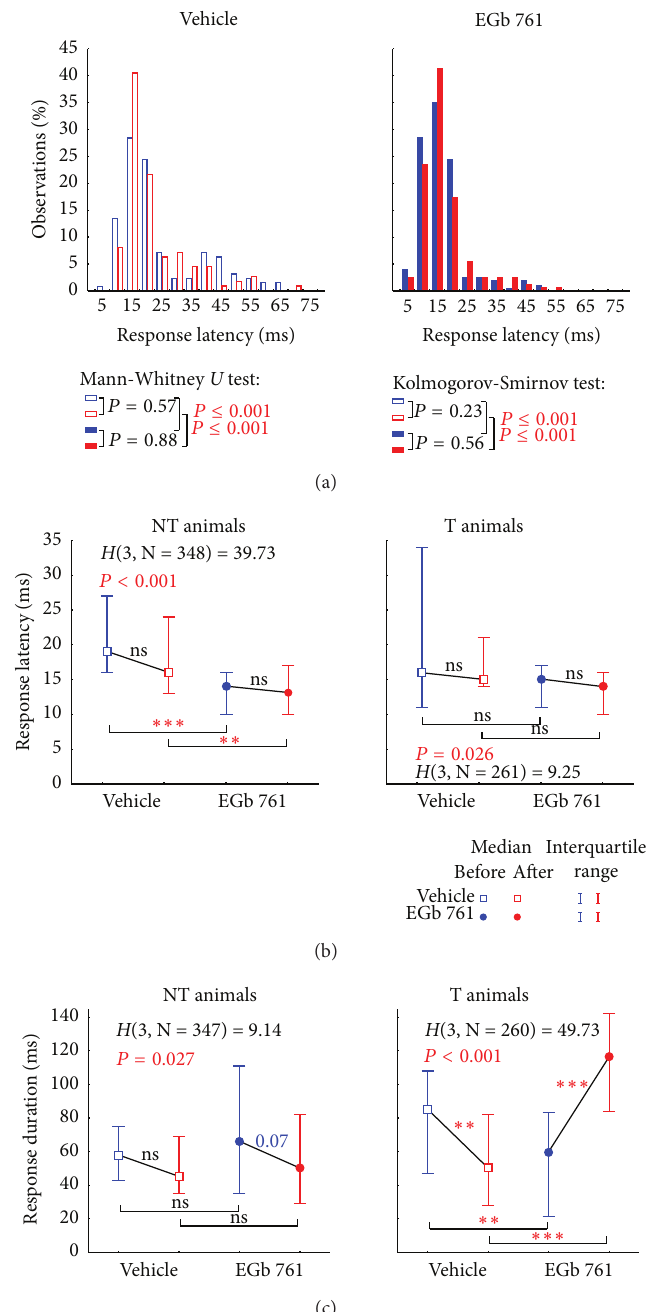
Figure 11: Distributions and Kruskal-Wallis-ANOVAs of neuronal response latency and duration in NT and T animals. (a) Distribution of response latencies (given in % observations binned into 5 ms bins) before (blue) and after (red) trauma in vehicle treated (open symbols) and EGb 761-treated animals (solid symbols) with the median values and interquartile range given above. Additionally, the statistics of the Mann-Whitney 𝑈 -tests (corrected for multiple comparisons)—testing of median and interquartile range—and the Kolmogorov-Smirnov tests for the testing of the whole distributions against each other are plotted. Note that in both tests only the two pre- and two postdatasets between the groups are significantly different from each other while pre- versus posttrauma data are equal in both animal groups. (b) Median neuronal response latency (in ms ± interquartile range) tested by Kruskal-Wallis-ANOVAs ( 𝐻 -statistics) and multiple comparisons between the subgroups (ns = not significant, ∗∗ 𝑃 < 0.01 , ∗∗∗ 𝑃 < 0.001 ) separated in nontinnitus and tinnitus perceiving animals treated with vehicle or EGb 761 before and after trauma. (c) Median neuronal response duration (in ms ± interquartile range) was analyzed as